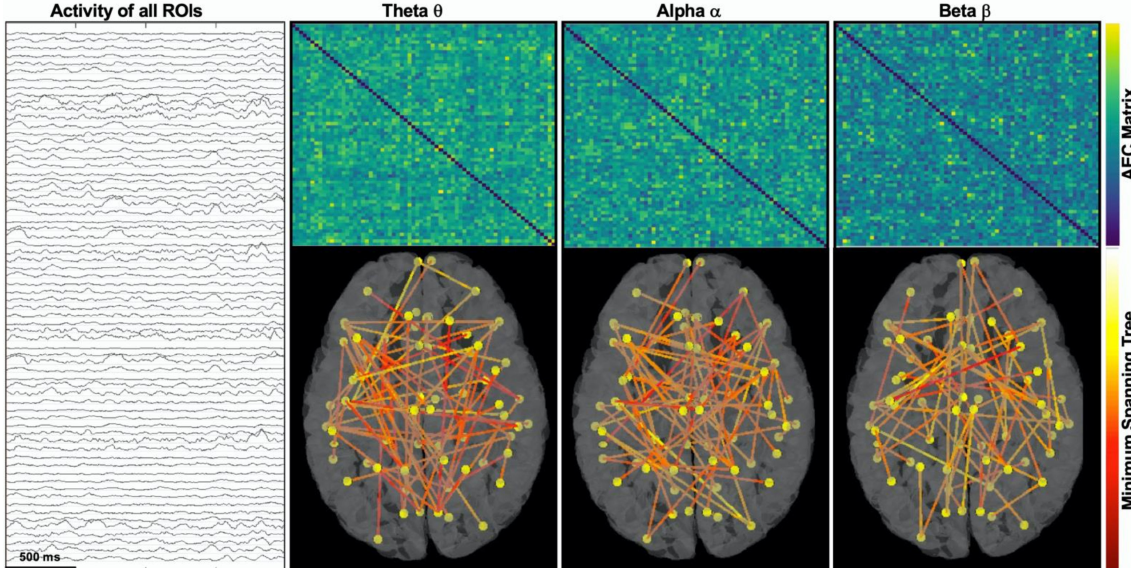
Figure 4. Example of source connectivity and minimum spanning tree in three frequency bands. Left panel shows one 2 s epoch of the background source activity (68 signals), whereby each signal corresponds to the reconstructed activity (via ESI) of each cortical ROI across the whole brain. From these reconstructed cortical signals, we estimated 5 connectivity matrices (via AEC method) and their minimum spanning tree (MST) for each frequency band. Here, we show matrices and graphs (MST) for theta, alpha, and beta bands (from the 2-s epoch displayed on the left), whereby each node (yellow dots) corresponds to an ROI and each edge (link or connection) is color-coded based on its cost (inverse of AEC value). Network centrality measures were estimated from each MST and then averaged across all analyzed